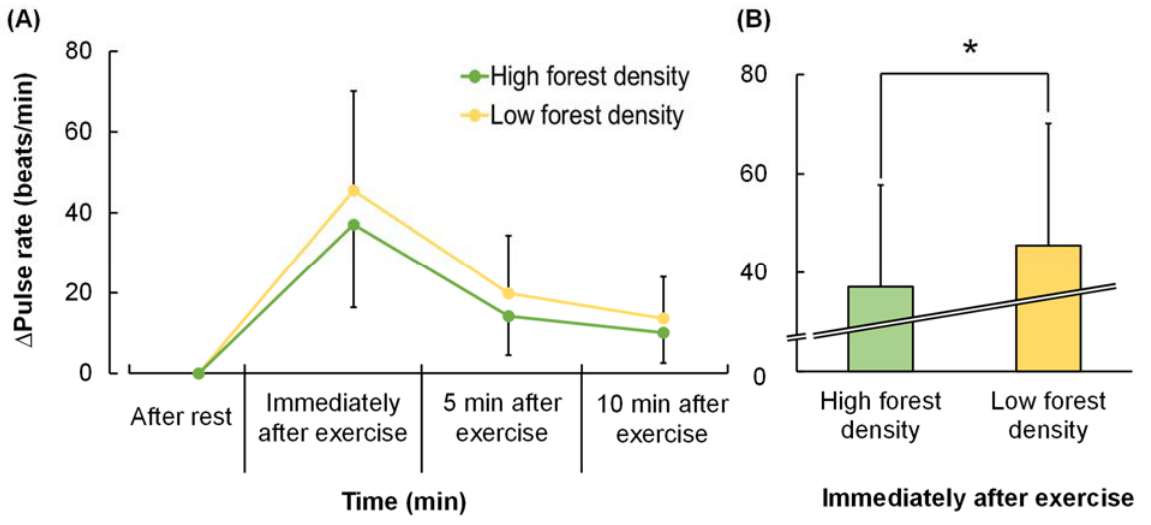
Figure 10. The average pulse rate of blood pressure between high forest density and low forest den ‐ sity. ( A ) Changes in the four periods of average pulse rate frequency. N = 17, mean ± standard error. ( B ) Effect on pulse rate frequency in “after exercise”. N = 17, mean ± standard error. * p < 0.05 using the paired t ‐ test.